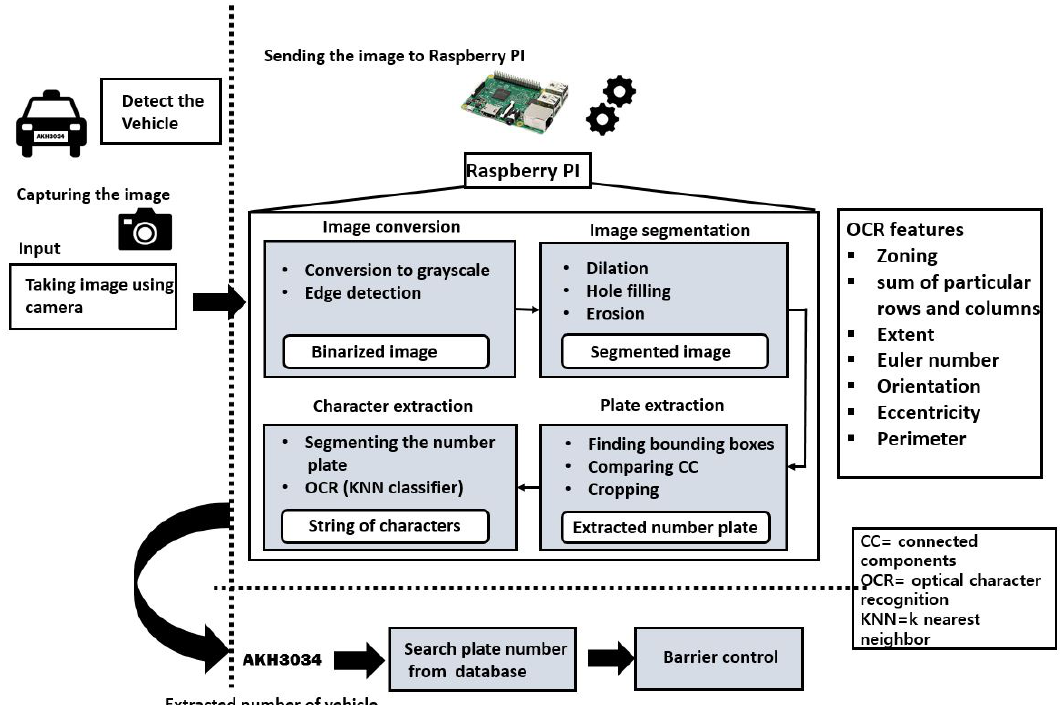
Figure 2. The proposed architecture of barrier access control for vehicle entrance using sensors platform and an image-based LP